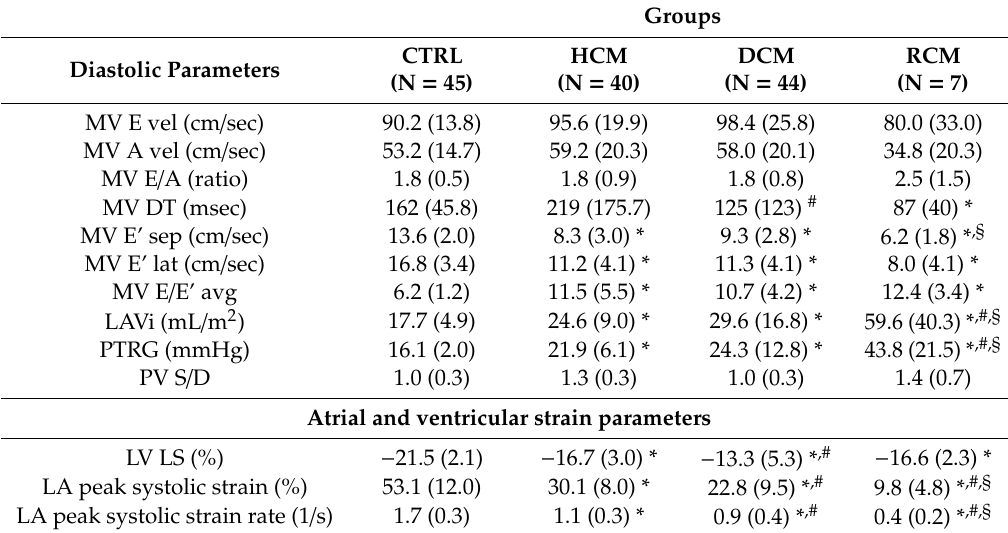
Table 2. Studied standard echo-doppler parameters and strain